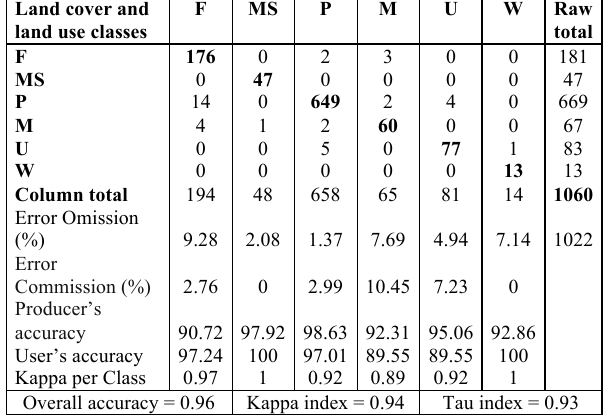
Table 1. Confusion matrix of the GEOBIA 2013 Landsat-8